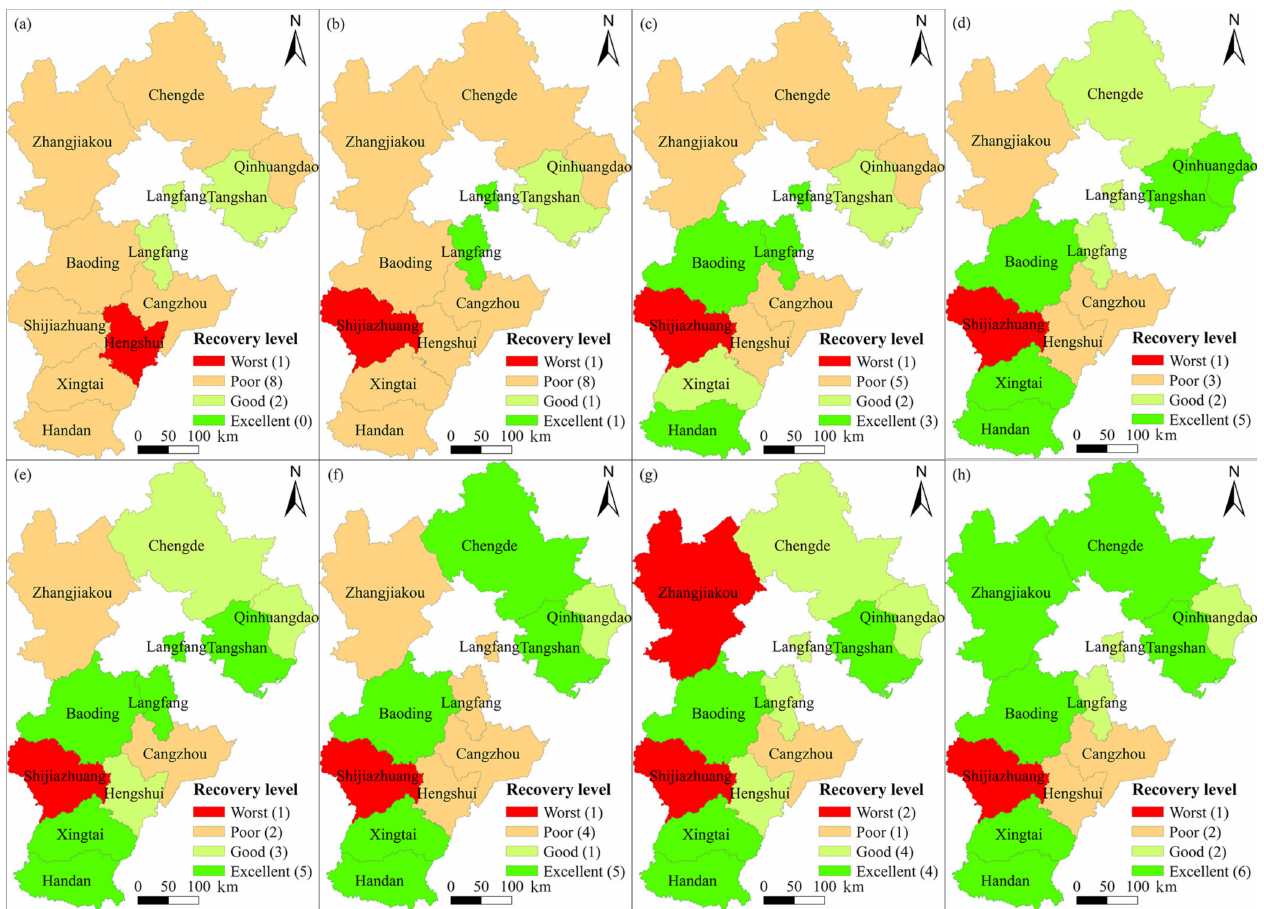
Figure 6. The levels of the economic recovery of prefecture-level cities in Hebei Province in Q1 ( a ), Q2 ( b ), Q3 ( c ), and Q4 ( d ) of 2020, and the levels of the economic recovery of prefecture-level cities in Hebei Province in Q1 ( e ), Q2 ( f ), Q3 ( g ), and Q4 ( h ) of